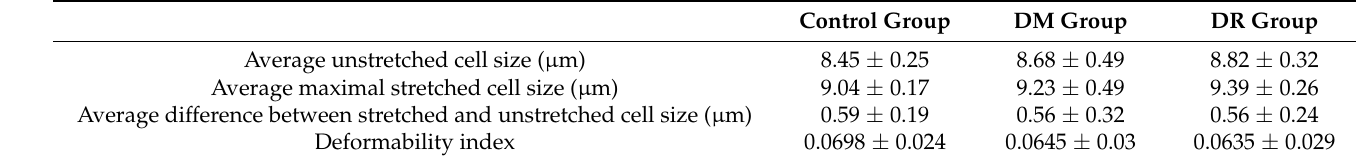
Table 7. Stretching parameters and deformability index of RBCs obtained by dual-beam optical tweezers for healthy control subjects and study subjects affected by diabetes mellitus (DM) and diabetic retinopathy (DR). Data are obtained with 925 cell cycles (5–10 cycles for single cell)